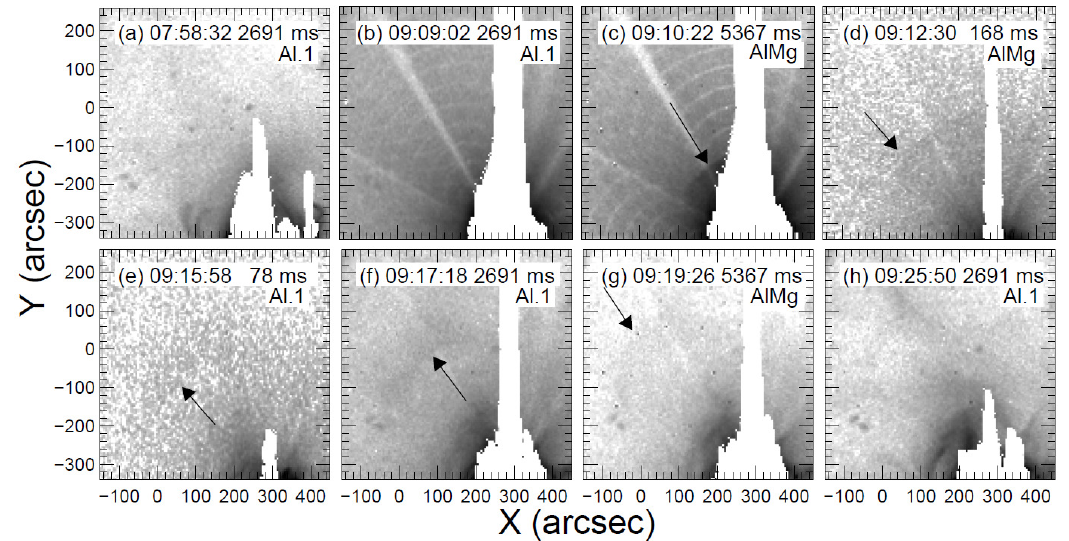
Figure 6: The coronal wave of 1997 Nov 3 observed in soft X-rays with Yohkoh/SXT. Shown are base images obtained with different filters (with reversed gray scale). The arrows indicate the sharp leading edge of the wave. Bright radial and circular features in the images are due to saturation effects from the flare. Image reproduced with permission from Khan and Aurass (2002), copyright by ESO. As their EUV counterparts, “SXT waves” are observed as fronts of increased coronal